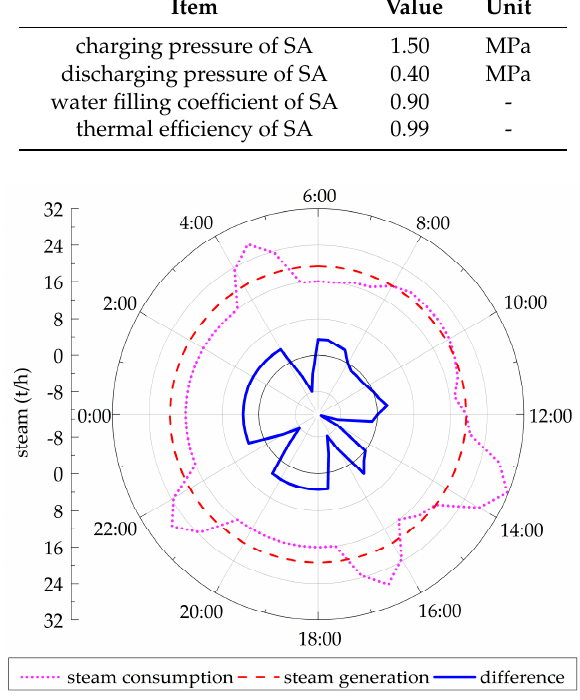
Figure 11. Daily steam consumption load curve. The dashed line denotes the steam generation; the short dot denotes the steam consumption; and the solid line denotes the difference between steam generation and steam consumption.